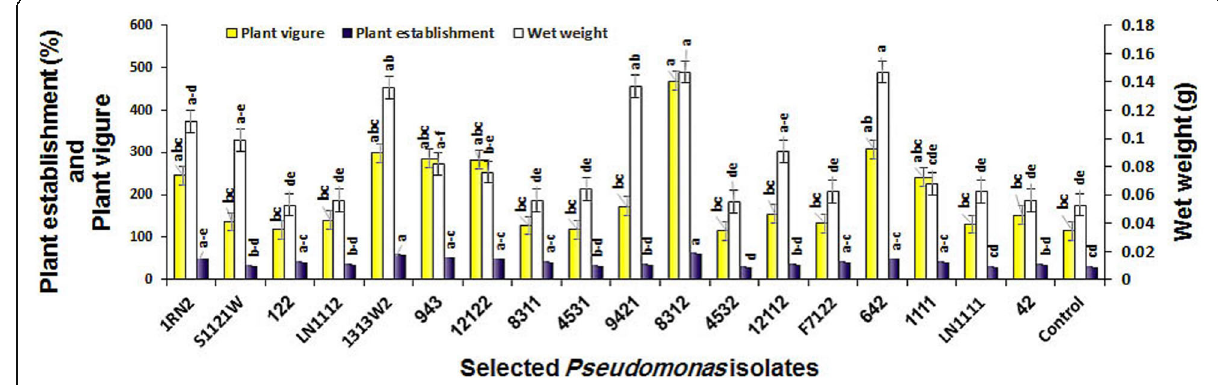
Fig. 6 Effect of canola seed priming by selected Pseudomonas isolates on wet weight, plant establishment and vigor of canola in greenhouse conditions. Each treatment had three replications and treatments with common letters in Duncan test at 5% level were not significantly different from each